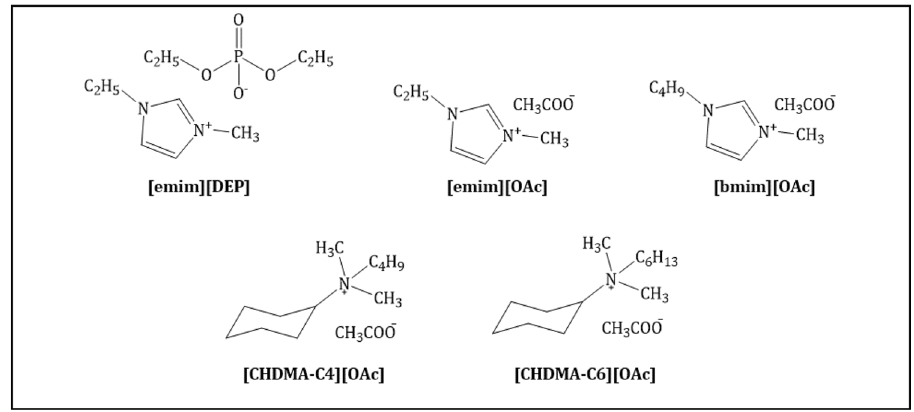
Figure 7. Ionic liquids chosen for pretreatment of stinging nettle stems and giant